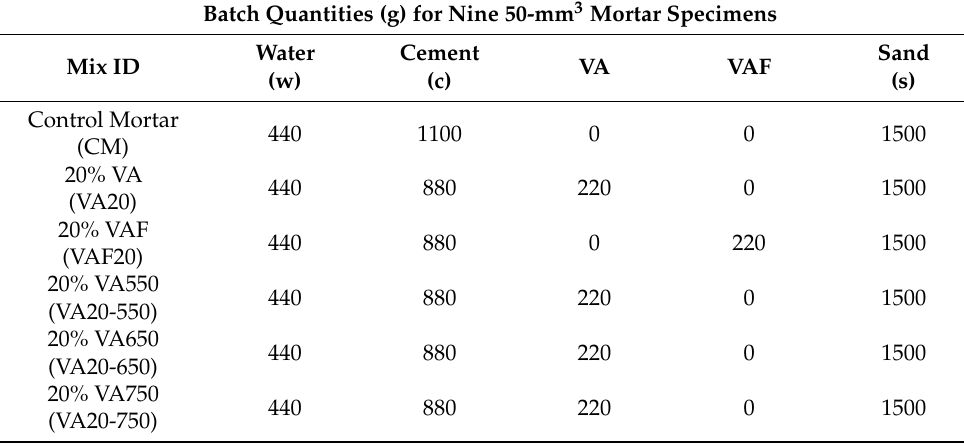
Table 2. Mixture proportions of mortar (w/cm = 0.40; cm:s =